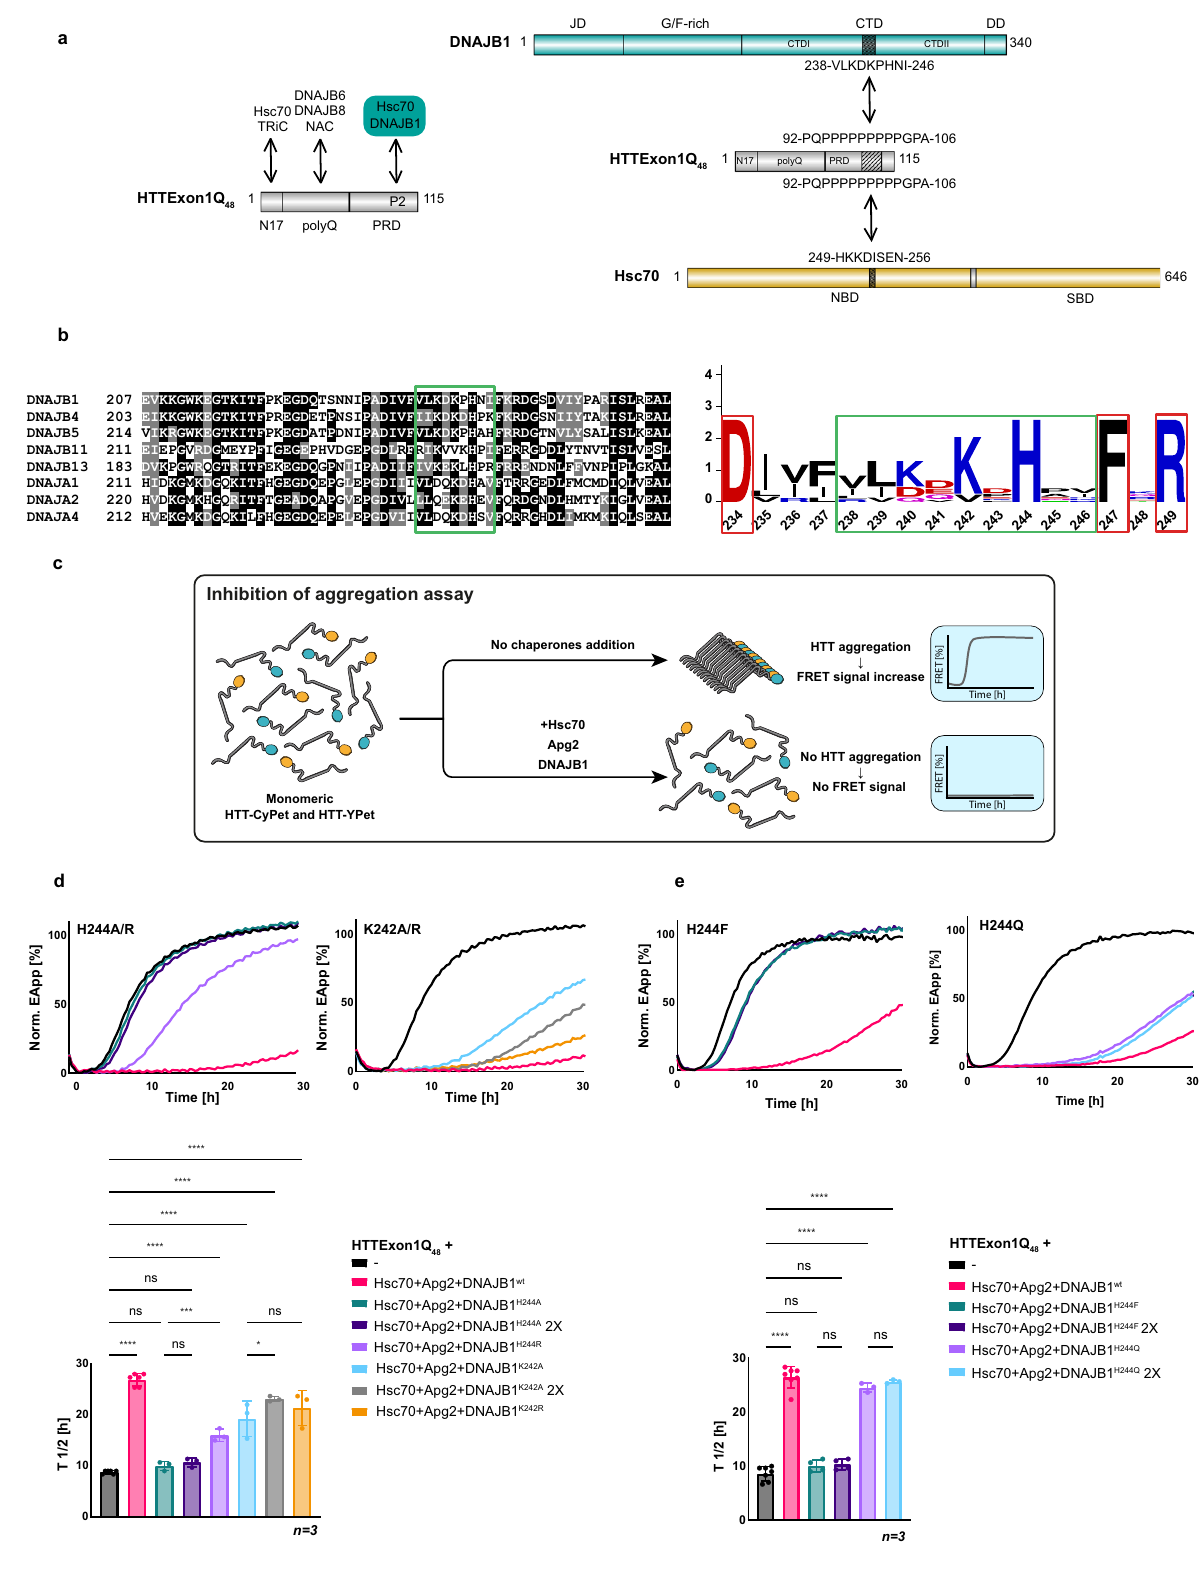
203 EIKKGWKEGTKITFPREGDETPNSIPADIVFIIKDKDHPKFKRDGSNIIYTAKISLREAL DNAJB5 214 VIKRGWKEGTKITFPKEGDATPDNIPADIVFVLKDKPHAHFRRDGTNVLYSALISLKEAL DNAJB11 211 EIEPGVRDGMEYPFIGEGEPHVDGEPGDLRFRIKVVKHPIFERRGDDLYTNVTISLVESL DNAJB13 183 DVKPGWRQGTRITFEKEGDQGPNIIPADIIFIVKEKLHPRFRRENDNLFFVNPIPLGKAL